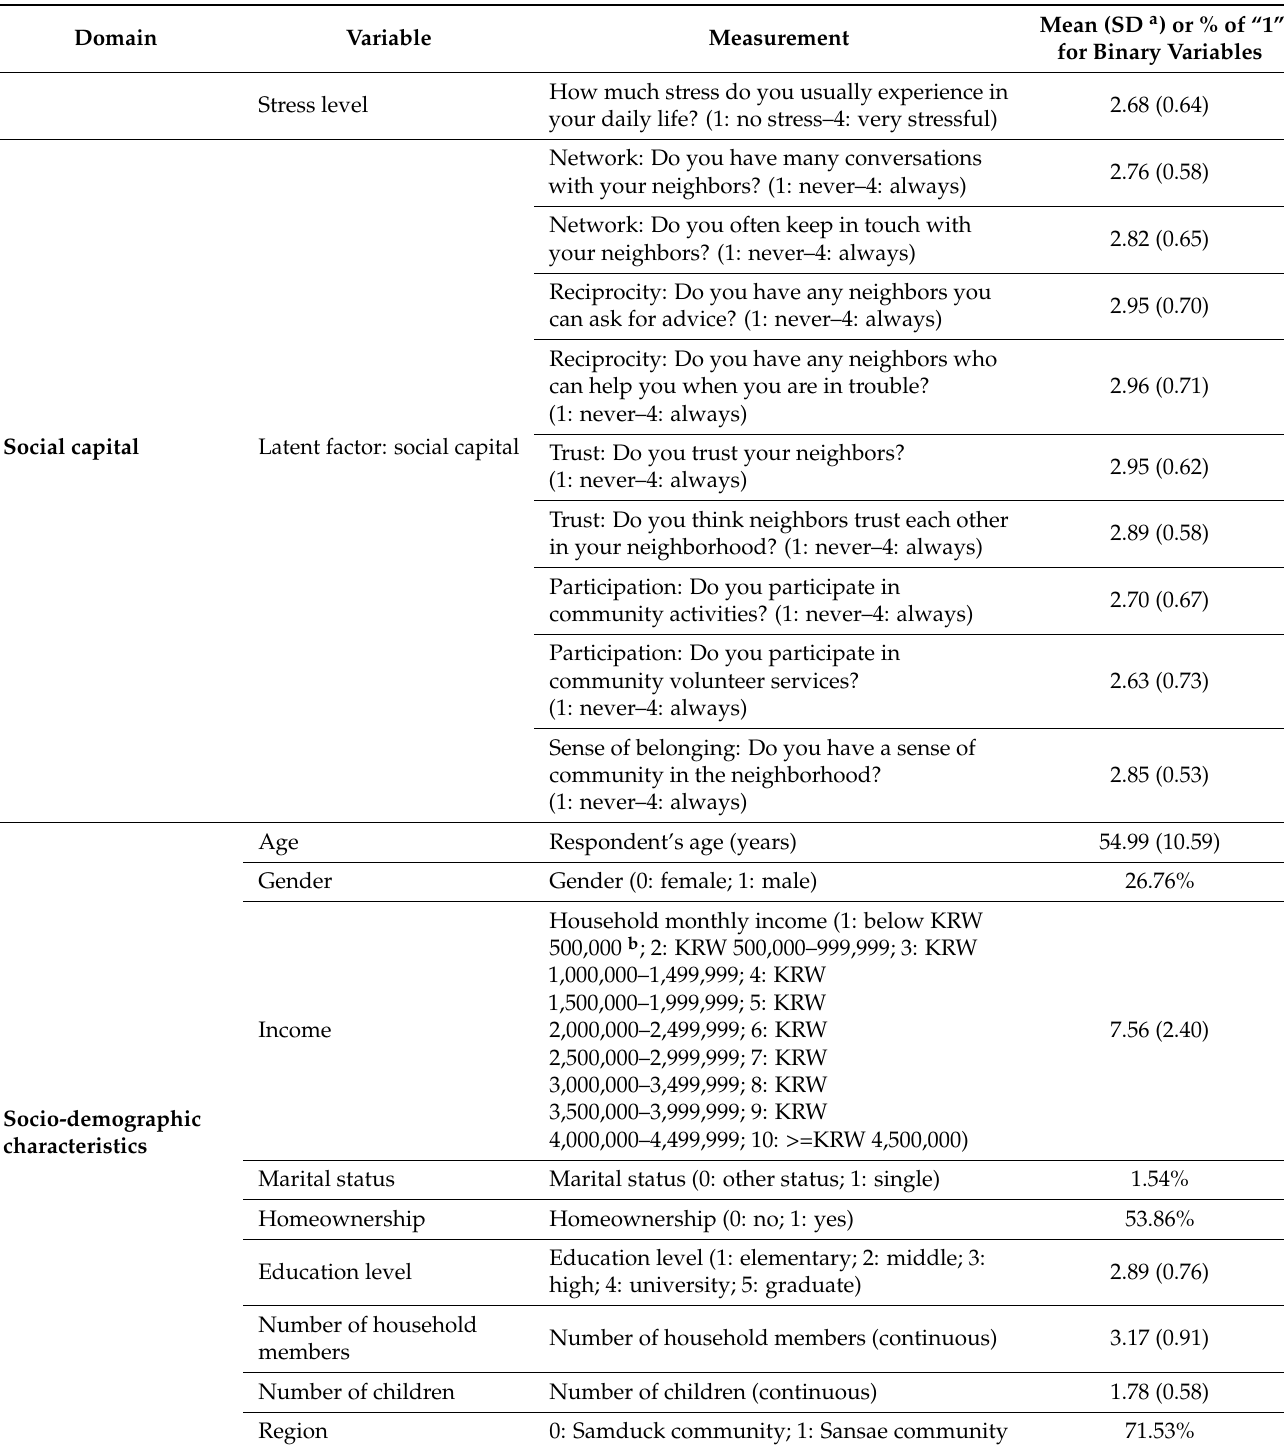
Table 1. Domains, variables, measurements, and descriptive